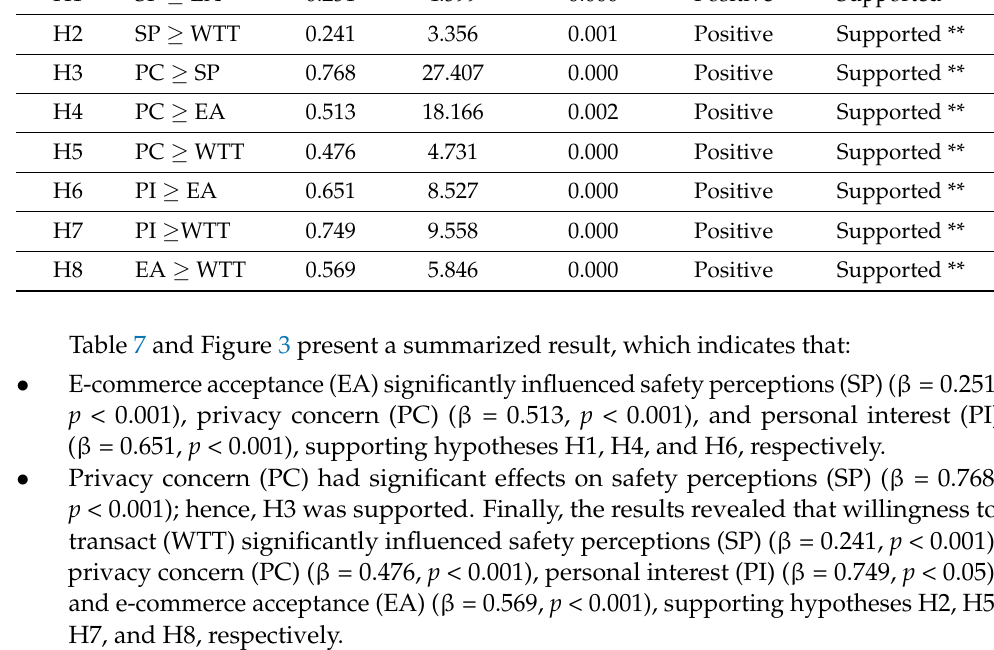
Table 7. Hypotheses testing of the research model (significant at p ** < = 0.01, p * < 0.05).